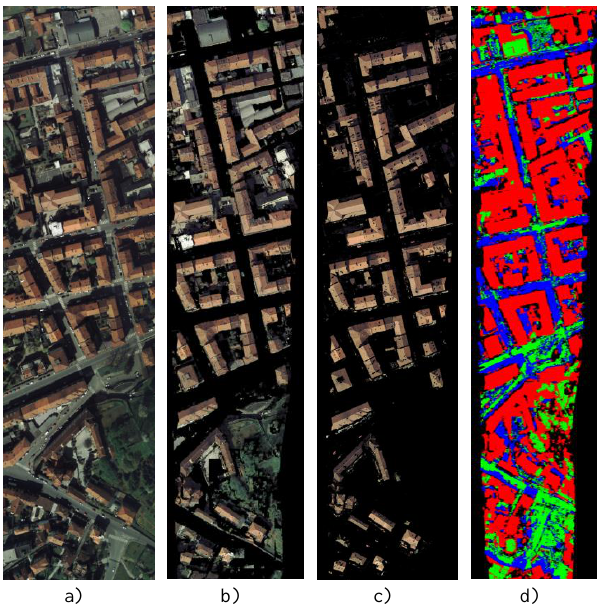
Figure 5: The analysed scene (a), the off-ground classification (b), the roof class provided by the spectral information (c) and the final 3-classs classification (d). Classification results: building in red, roads in blue and vegetation in